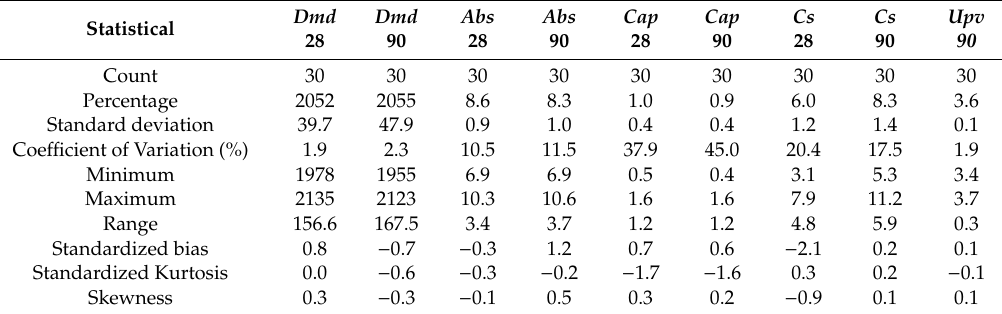
Table 7. Statistical summary of all the variables analyzed.